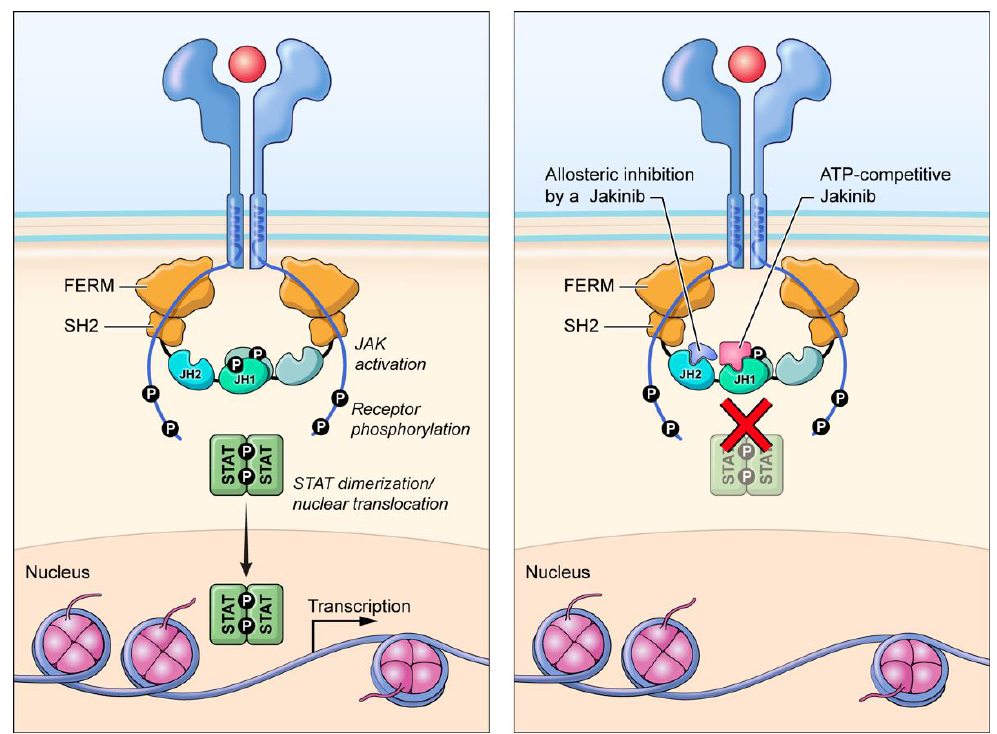
Figure 1. Alternate mechanisms of JAK inhibition. Deucravacitinib inhibits TYK2 activation by interacting with the pseudokinase (JH2) domain (allosteric inhibition), while first-generation jakinibs inhibit enzymatic activity by binding to the ATP-binding (JH1) domain (competitive inhibition).